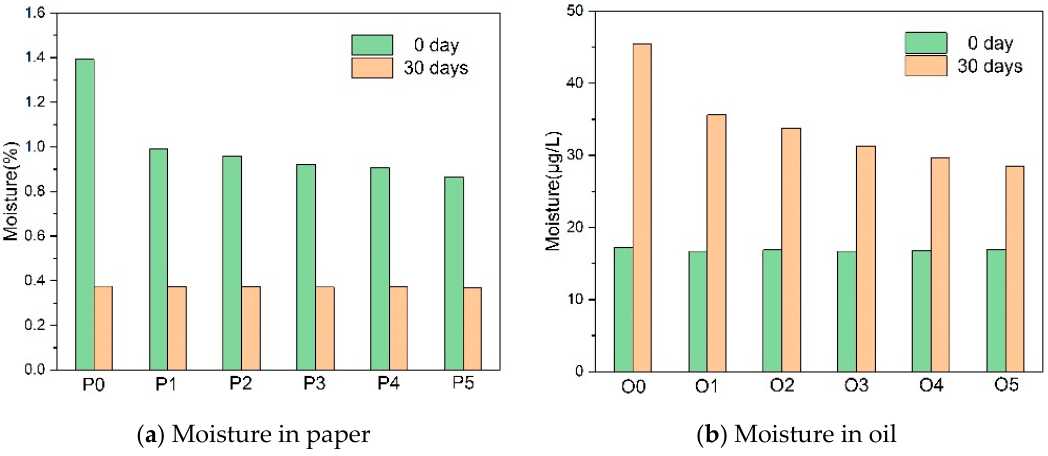
Figure 8. The variation of the moisture in the paper and the oil with the thermal aging.